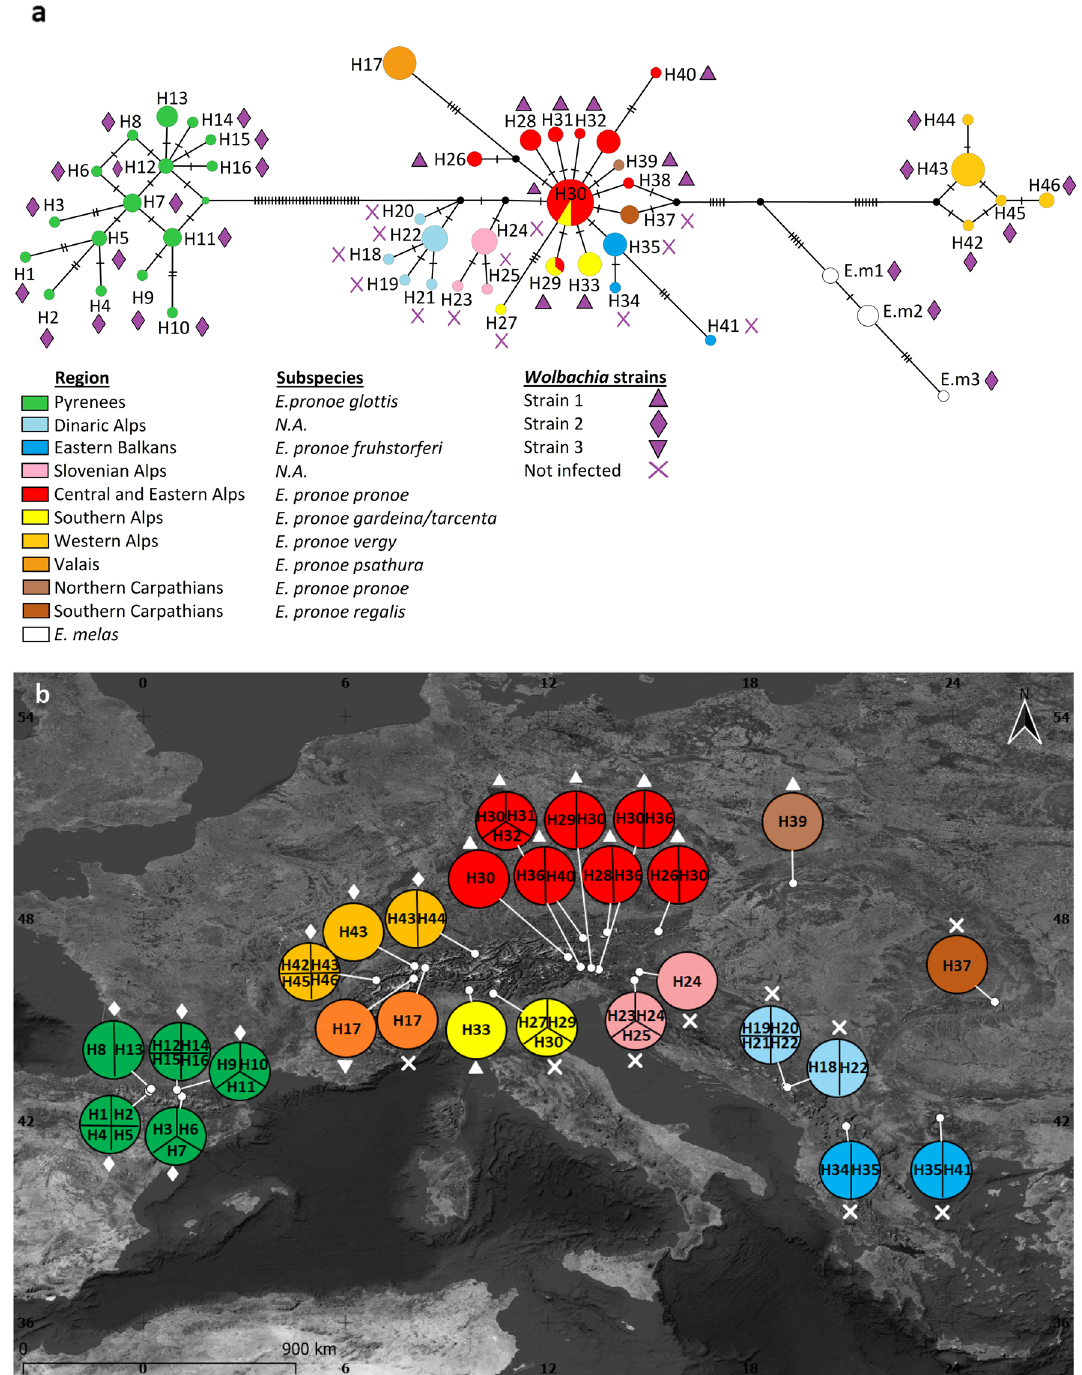
Figure 1. ( a ) TCS haplotype network based on the concatenated mtDNA haplotypes (COI, NDI) of Erebia pronoe . Mutational steps are shown by the number of hatch marks. The colour codes of each region and the corresponding subspecies are given in the legend (N.A. = no subspecies name available for this region). The reference haplotypes of E. melas are given in white. Detected Wolbachia infection strains are indicated by a symbol next to each haplotype. ( b ) Distribution of the identified concatenated mtDNA haplotypes (COI, NDI) among the populations of E. pronoe . The map was created with Qgis v.3.10.10 (Available online: http:// qgis. osgeo.